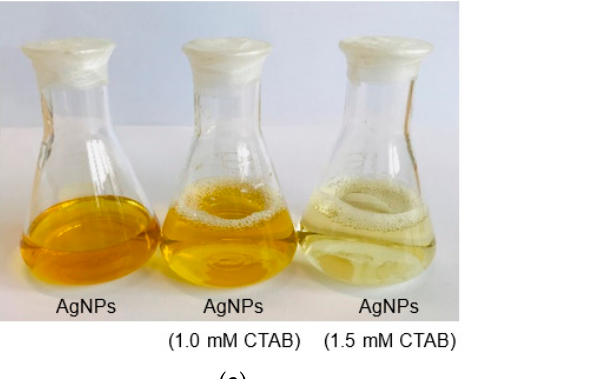
Figure 1. ( a ) Digital photographs of the solutions of Ag nanoparticles synthesized without the use of CTAB, with 1.0 mM CTAB and 1.5 mM CTAB. ( b ) UV–vis spectra of the AgNPs (1.0 mM CTAB), AgNPs (1.5 mM CTAB) and AgNPs without CTAB.